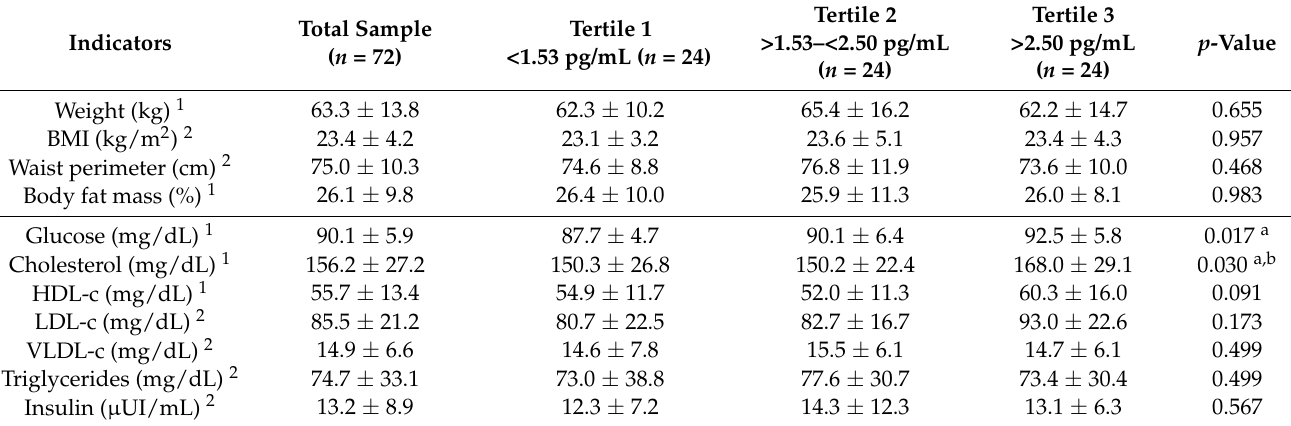
Table 7. Anthropometric and biochemical indicators regarding the IL-6 tertiles.